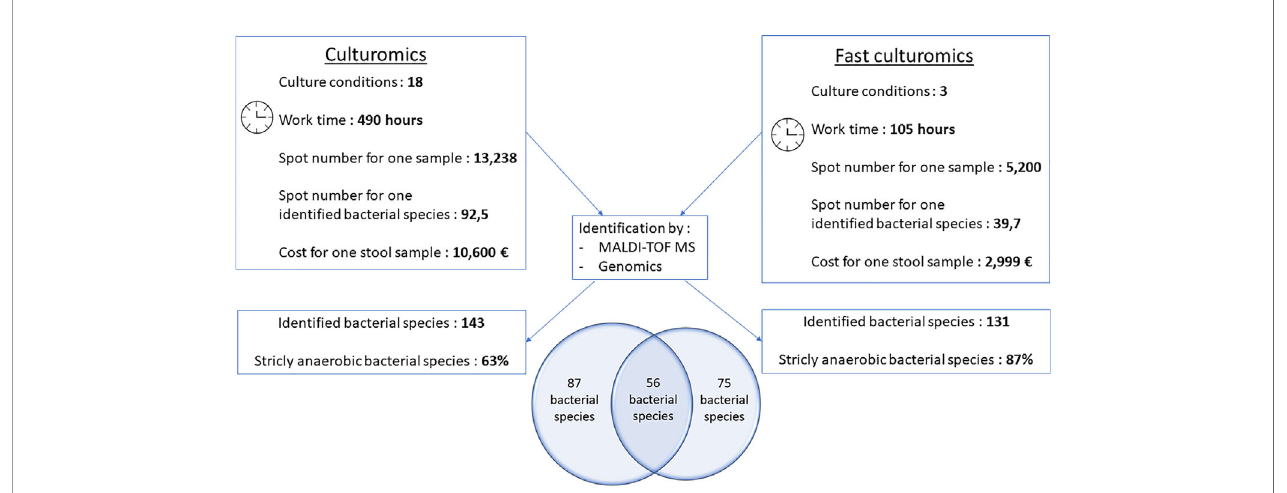
FIGURE 4 | Comparative fi gure between standard culturomics and rapid culturomics. By adding both standard and fast protocol, 218 bacterial species were identi fi ed from the same sample, with 87 bacteria found only when using the 18 culture conditions of the standard culturomics, 75 using only the fast culturomics, and 56 isolated by both